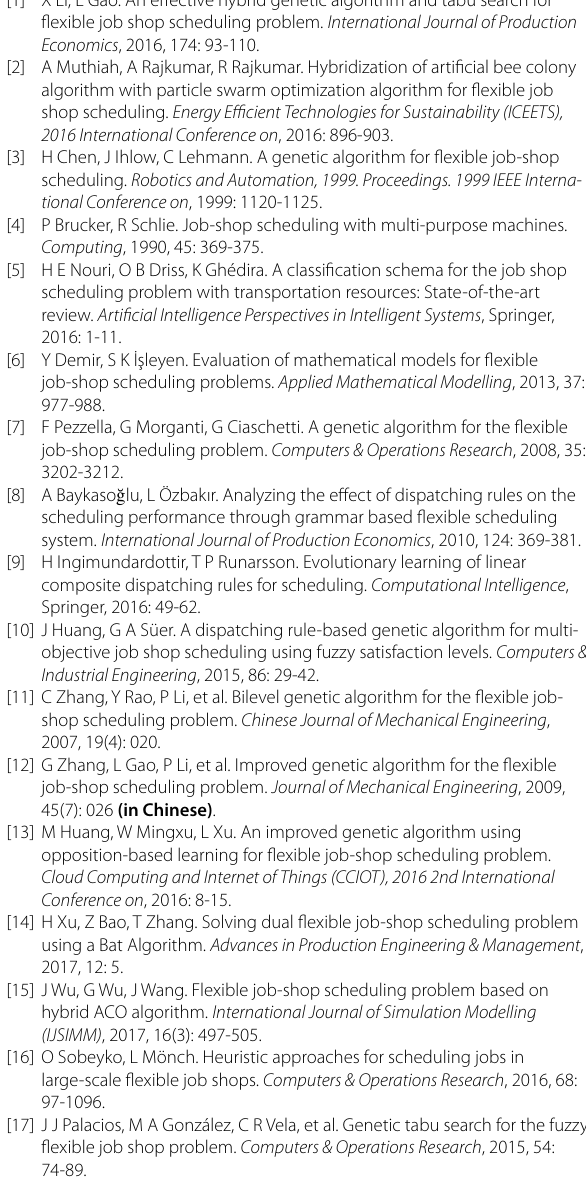
Figure 11 Results comparison for large-scale